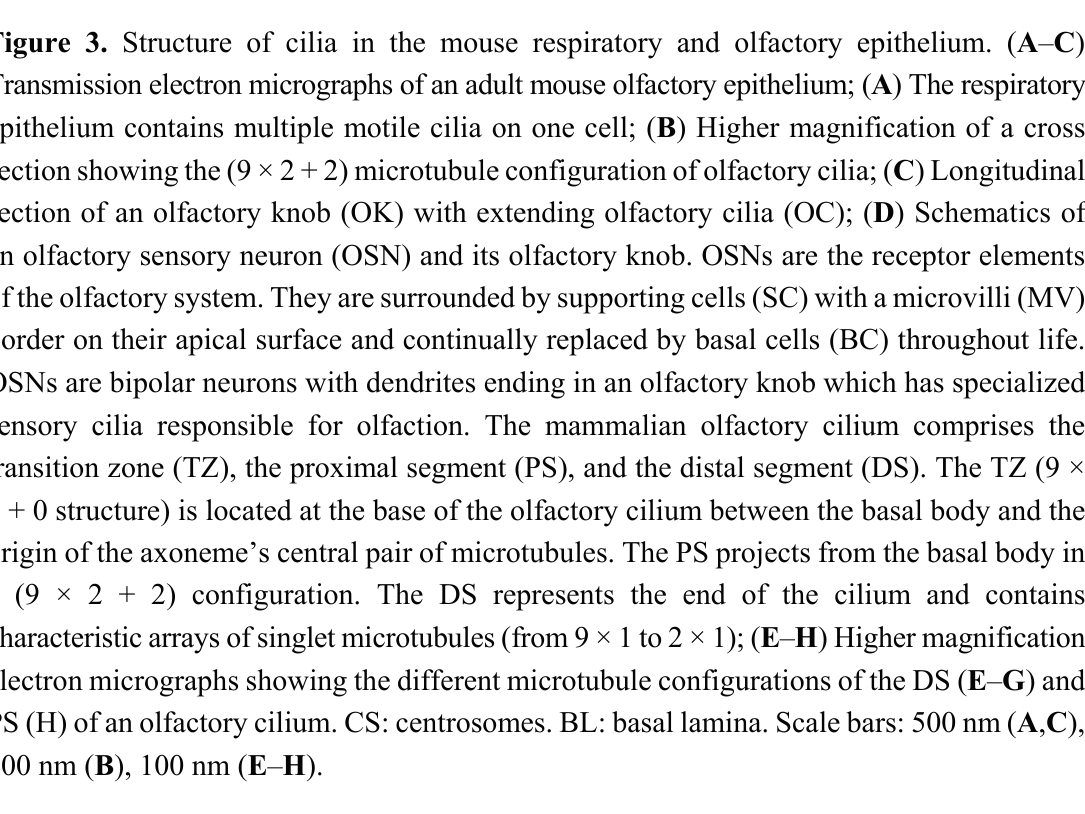
PS (H) of an olfactory cilium. CS: centrosomes. BL: basal lamina. Scale bars: 500 nm ( A , C ), 200 nm ( B ), 100 nm ( E – H